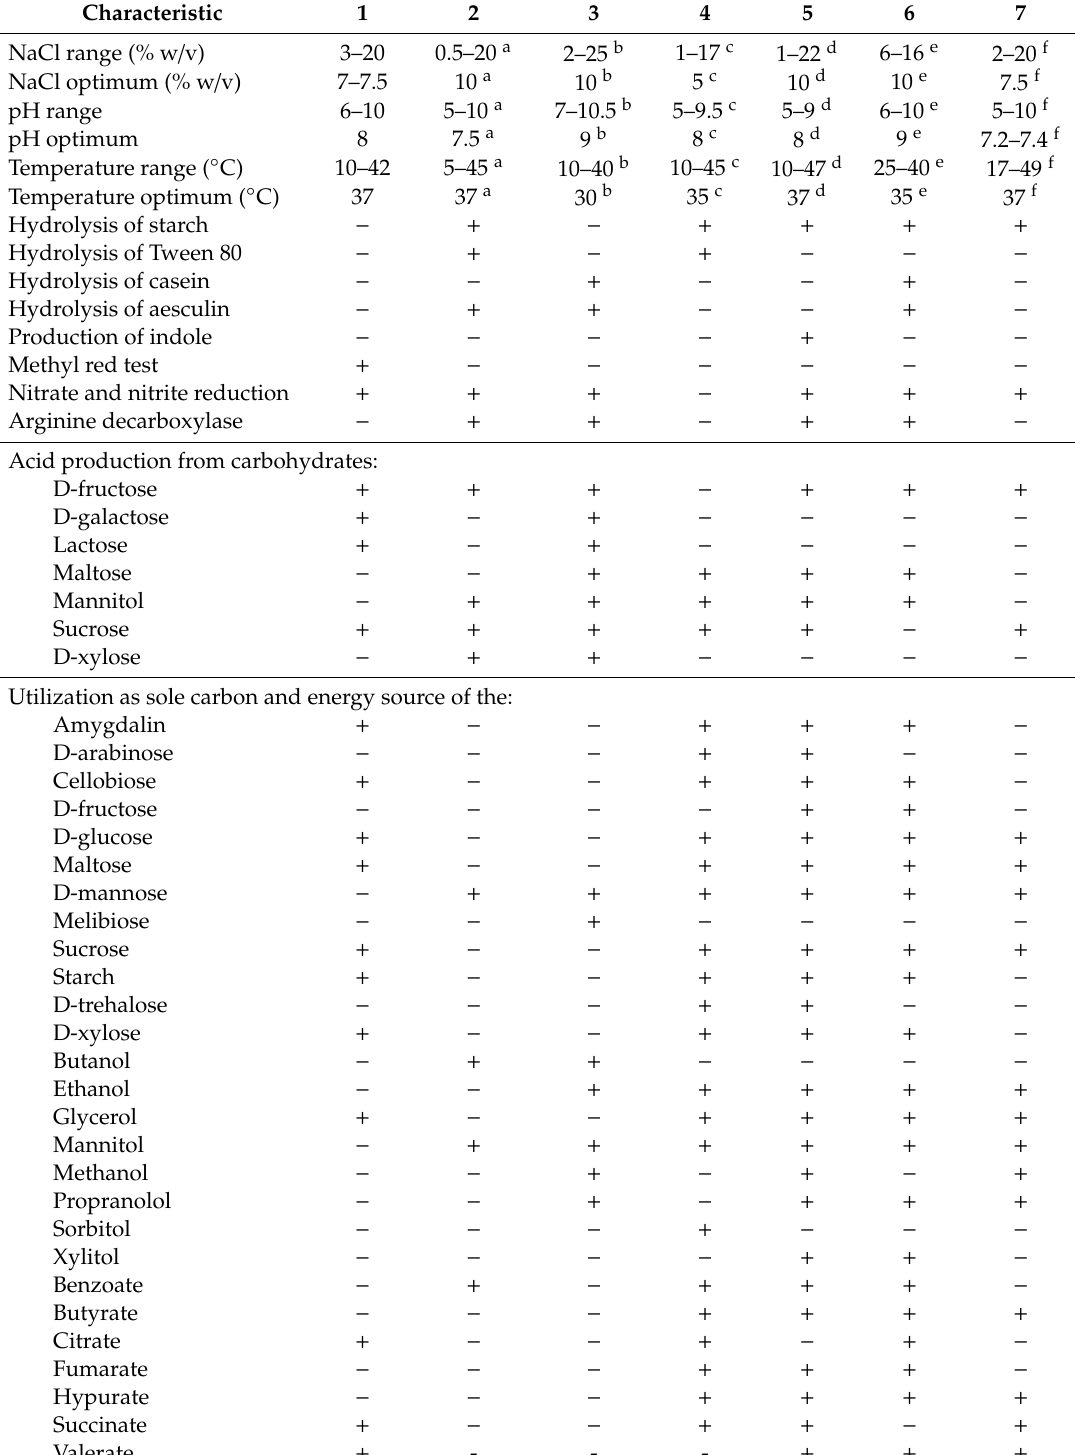
Table 2. Di ff erential characteristics between strain S35 T and the type strains of the closely related species and subspecies of the genus Salinivibrio